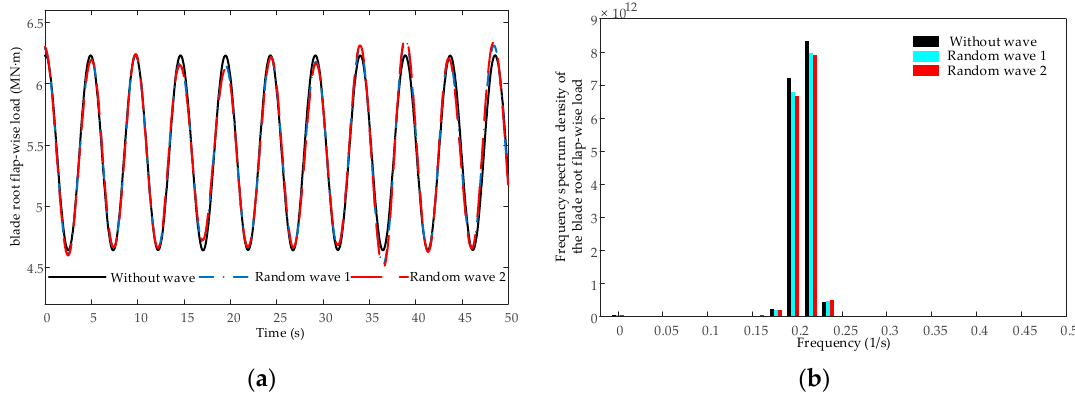
Figure 8. Time domain and frequency domain results of the blade root flap-wise load without and with random wave: ( a ) The blade root flap-wise load; ( b ) Frequency spectrum density of the blade root flap-wise load.